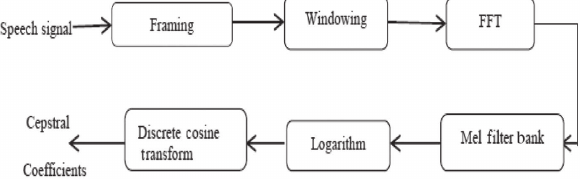
Figure 7: Block Diagram of MFCC Feature